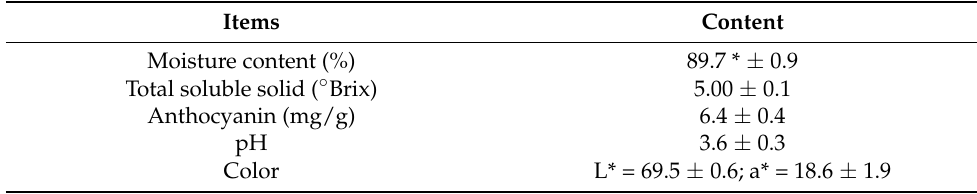
Table 1. A fewphysical and chemical characteristics of mulberry.